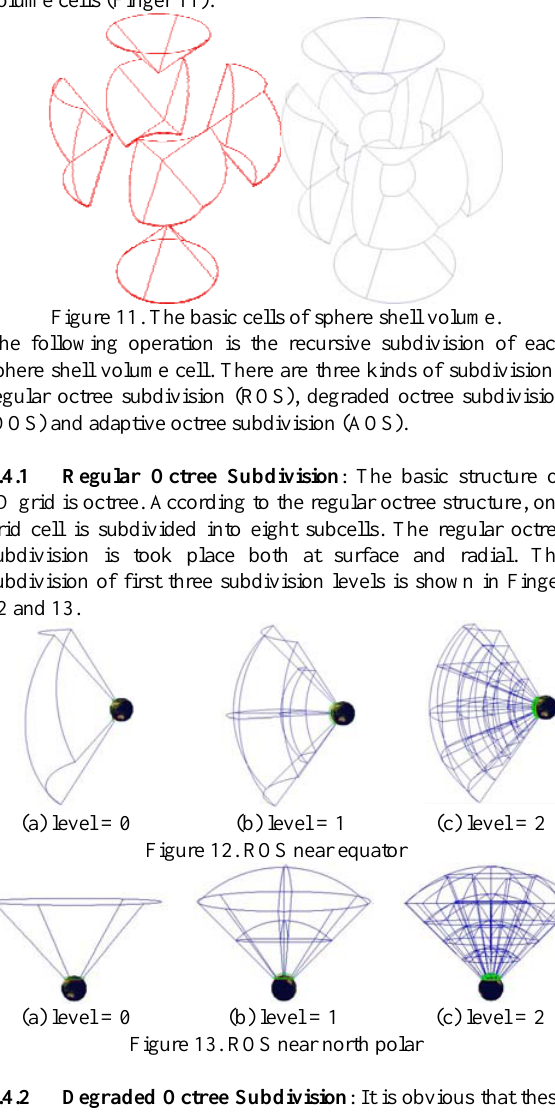
Figure 14. DOS near equator